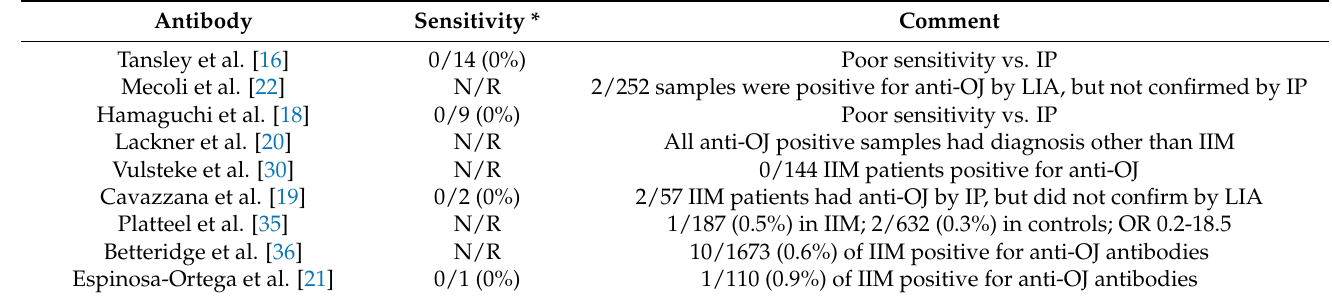
Table 2. Overview of studies on anti-OJ antibodies and sensitivity of line immunoassay vs. immuno-